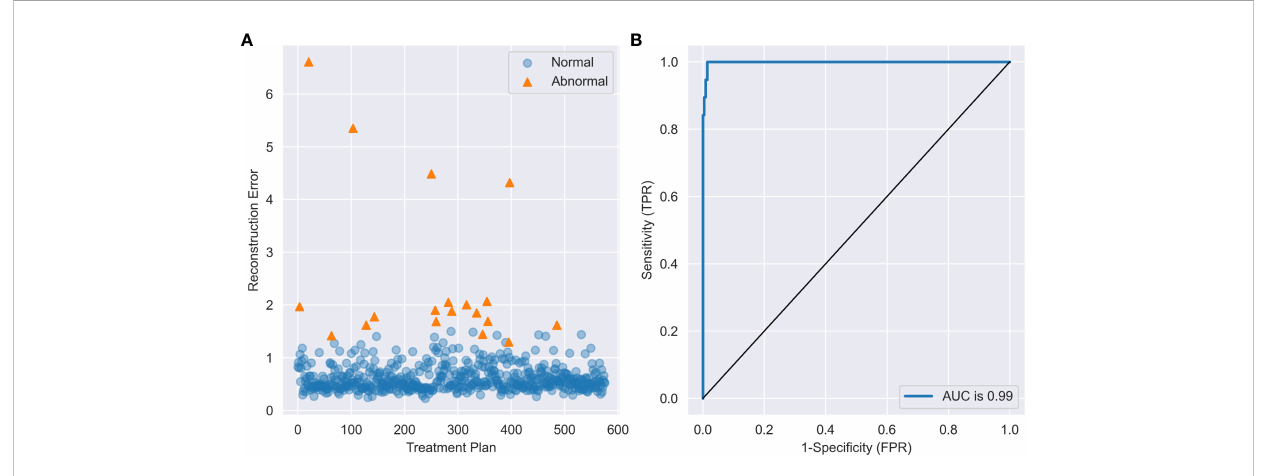
FIGURE 2 (A) The reconstruction error distribution of all data and (B) the ROC plot with AE6.